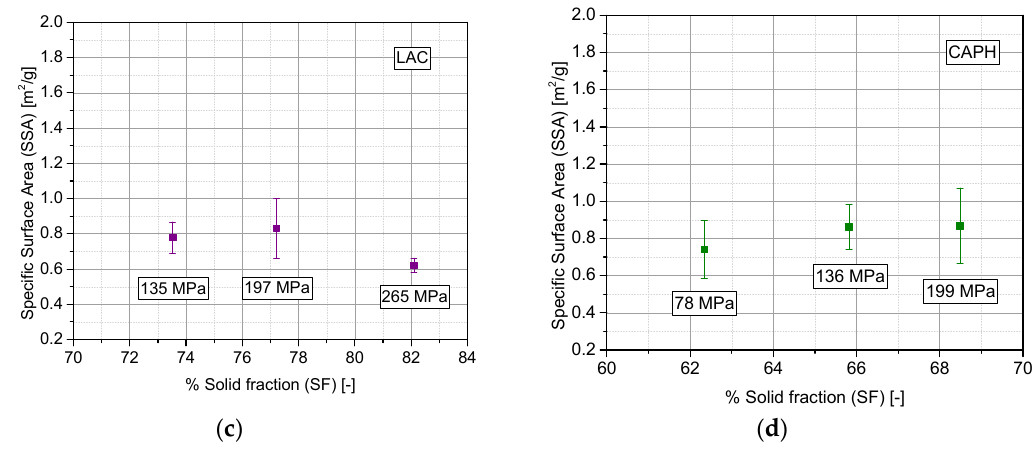
Figure 7. Surface area determination with Brunauer, Emmett, and Teller (BET) ( n = 4, for each material and compaction pressure); ( a ) MCC-A; ( b ) MCC-P; ( c ) LAC; ( d ) CAPH.